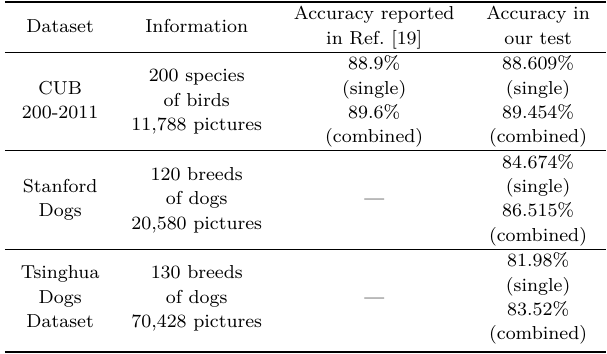
Table 2 Performance of PMG [19] on different